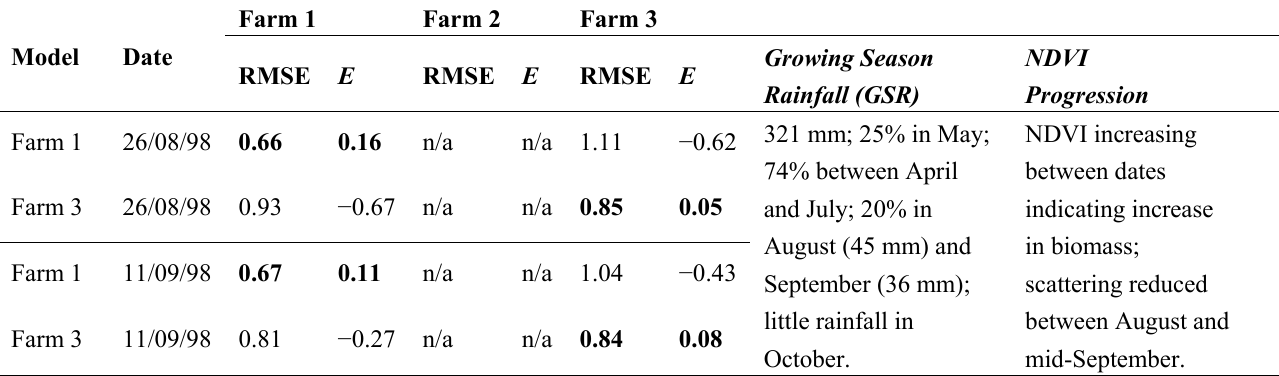
Table 4. Model and yield prediction efficiency criteria for 1998 Landsat imagery-Root Mean Square Error (RMSE) and the Nash-Sutcliffe Efficiency Criteria ( E ). Values in bold italics represent efficiency criteria for the calibration models. Descriptions of 1998 Growing season rainfall, NDVI progression and interpretations of results.